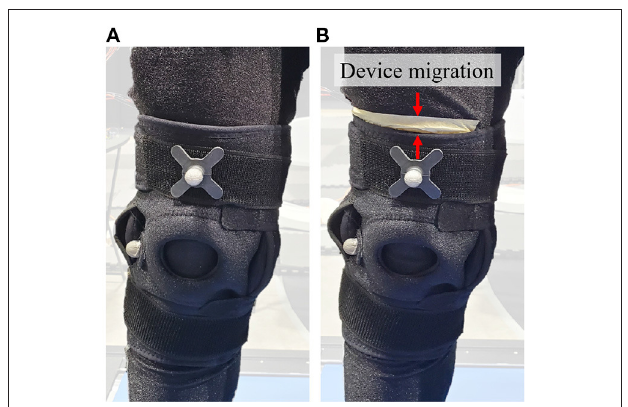
FIGURE 4 | Device Migration, (A) the brace at the beginning of the trial, (B) the brace at the end of the trial with the white tape marking the reference for measuring device migration. Red arrows show device migration as labeled on the figure.